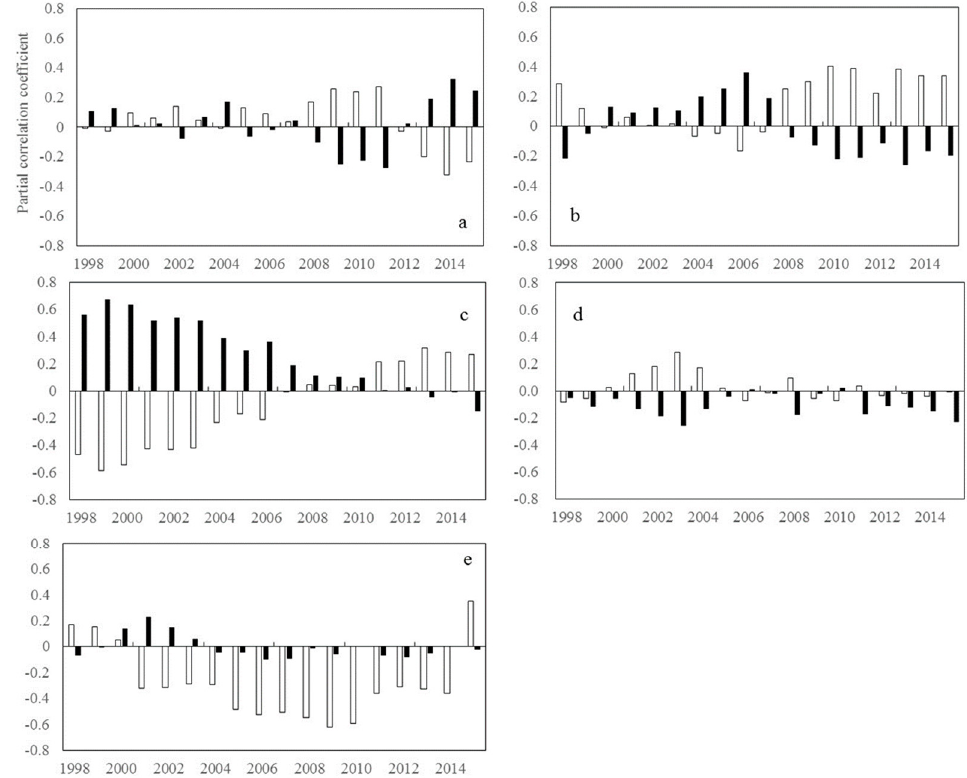
Figure 4. Temporal variations in the partial correlation coefficients between mean NDVI and the diurnal temperature (T max and T min ) in autumn for each 17-year moving window across latitudes intervals. ( a – e represents latitudes intervals at 60 ◦ ~90 ◦ N, 30 ◦ ~60 ◦ N, 0 ◦ ~30 ◦ N, − 30 ◦ ~0 ◦ S, and − 60 ◦ ~0 ◦ S, respectively (N and S indicates the Northern and southern hemisphere, respectively). The x axis is the last year of the 17-year moving-window (for example, 1998 stands for a moving-window from 1982 to 1998, . . . , 2015 stands for a moving-window from 1999 to 2015). The Y axis is the partial correlation coefficients.).